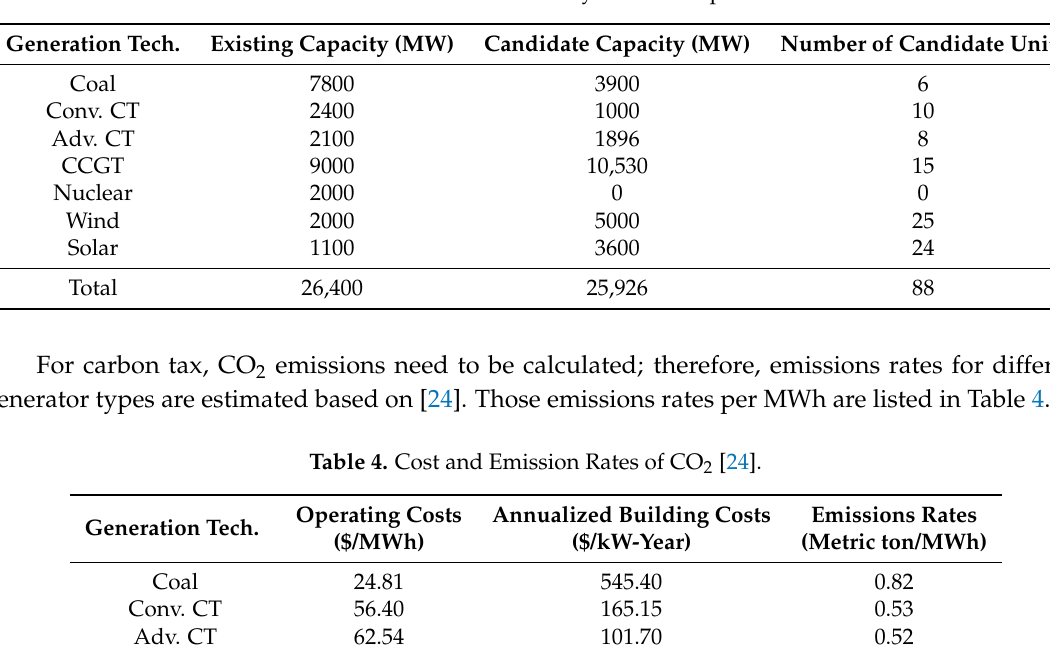
Table 3. IEEE 300-bus Test System Description.